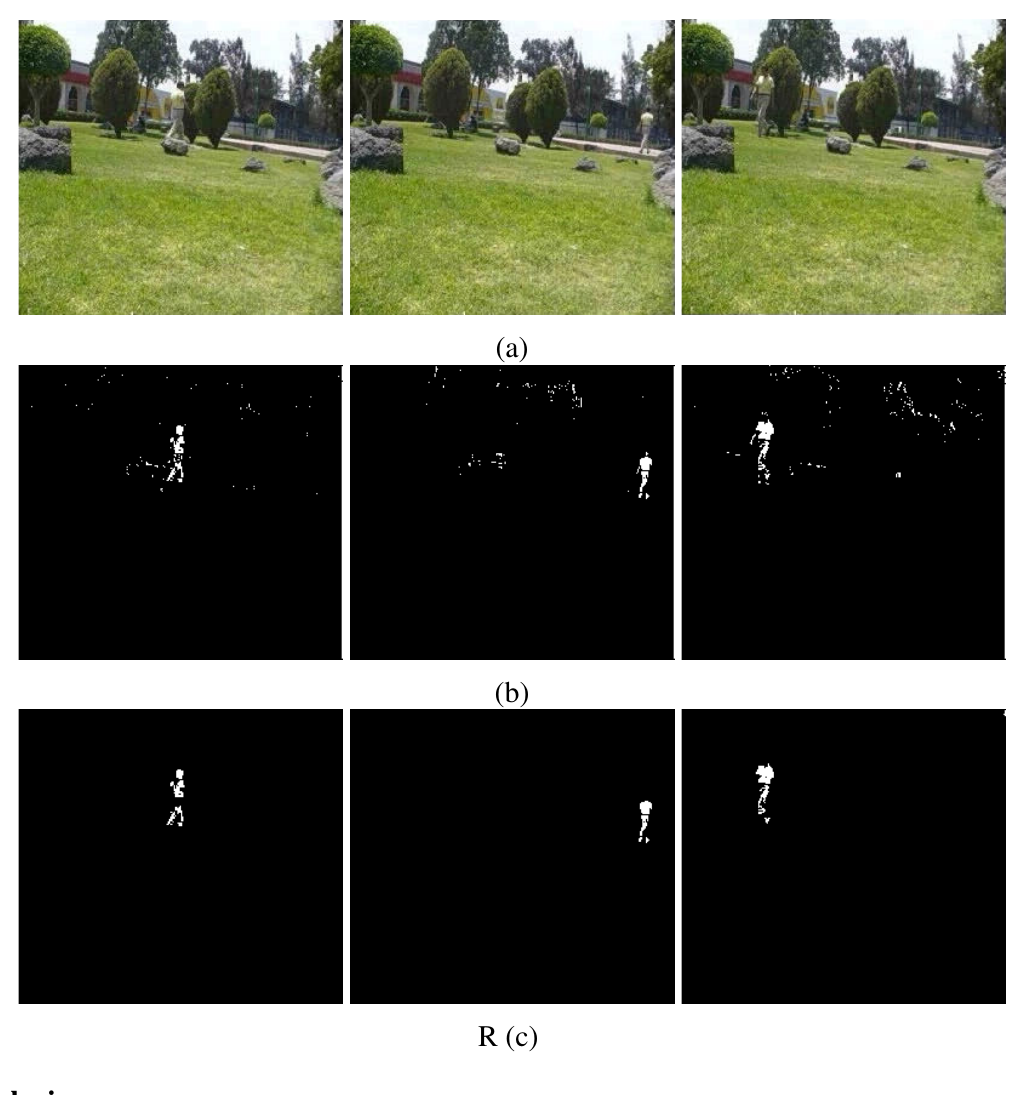
Figure 11. The enhancement of binary motion maps. The motion objects are better defined, and the noise effects are discarded. In (a) the original frames; in (b) the estimation of B ( x ) , e B ( x ) and in (c) the enhancement map